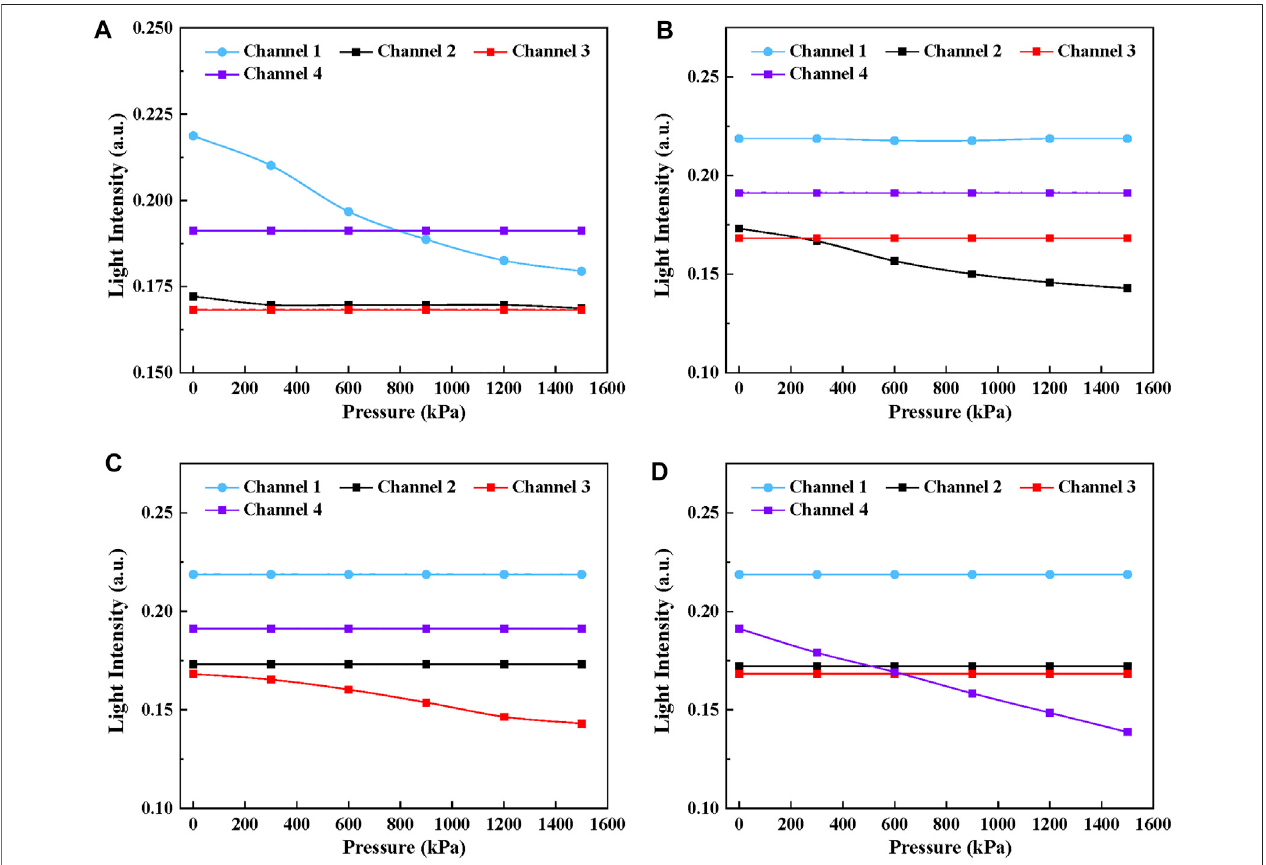
FIGURE 5 | The simulation results of the tactile sensor with the pressure ranging from 0 to 1,500 kPa applied. (A) Channel 1, (B) Channel 2, (C) Channel 3, (D) Channel 4